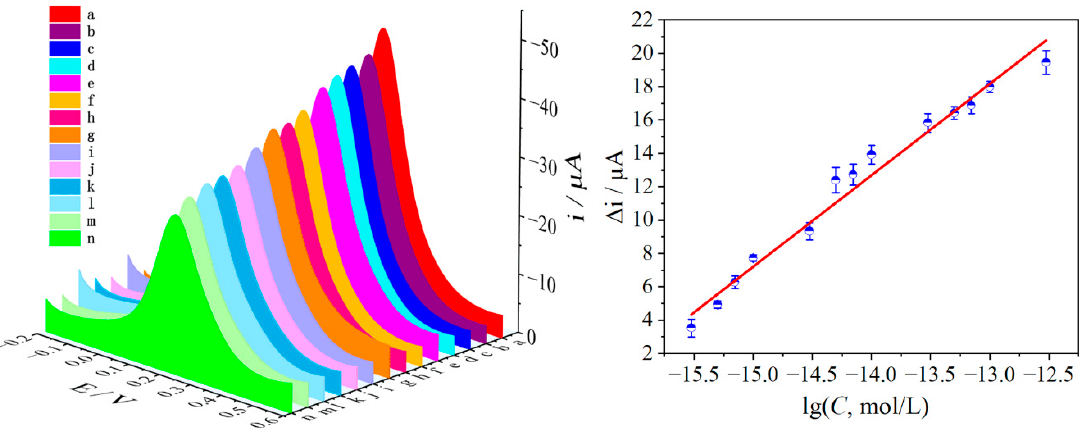
Figure 4. The DPV response of MIPs/dsDNA sensor to L-Pen on the 0.005 mol/L K 4 [Fe(CN) 6 ]/K 3 [Fe(CN) 6 ] (contain 0.1 mol/L KCl) and corresponding calibration curves (a~n: the concentration of L-Pen were 0, 3.0 × 10 − 16 , 5.0 × 10 − 16 , 7.0 × 10 − 16 , 1.0 × 10 − 15 , 3.0 × 10 − 15 , 5.0 × 10 − 15 , 7.0 × 10 − 15 , 1.0 × 10 − 14 , 3.0 × 10 − 14 , 5.0 × 10 − 14 , 7.0 × 10 − 14 , 1.0 × 10 − 13 , 3.0 × 10 − 13 mol/L L-Pen) (working potential from +0.6 V to − 0.2 V. Error bar represents the standard deviation of three repetitive experiments).